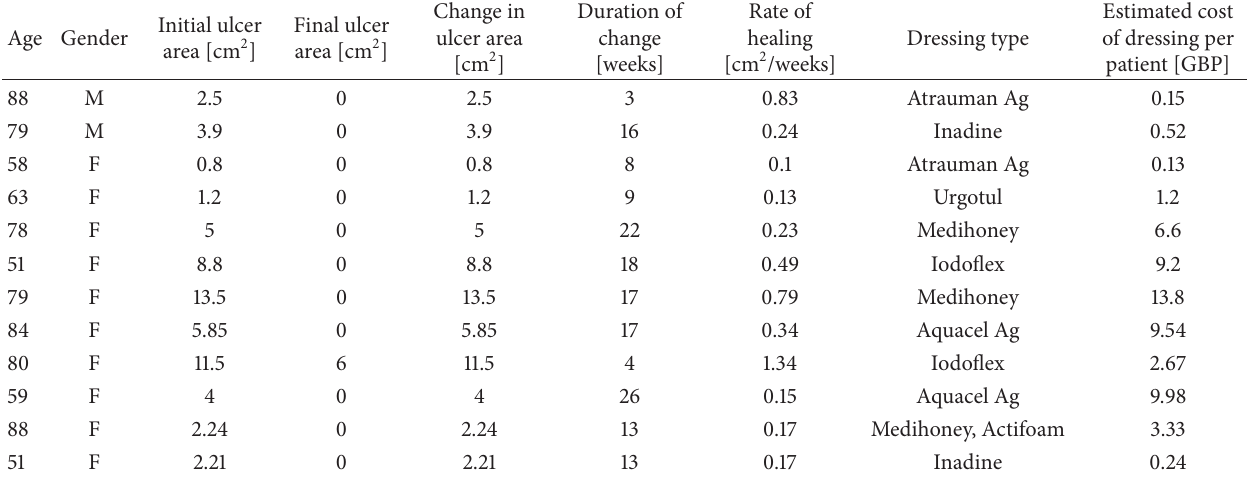
Table 2: Results for different types of modern dressings. The mean healing rate was 0.415 cm 2 /week with a standard deviation of 0.383 and the mean cost of dressings was 4.78 GBP with a standard deviation of 4.816. The standard error was 0.111.